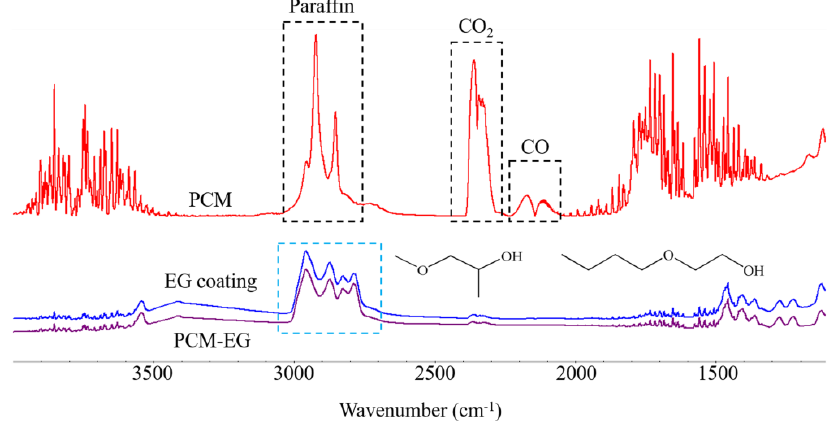
Figure 5. In situ Fourier transfer infrared spectrometry (FTIR) spectra of PCM, PCM-EG and EG coating at 150 °C.